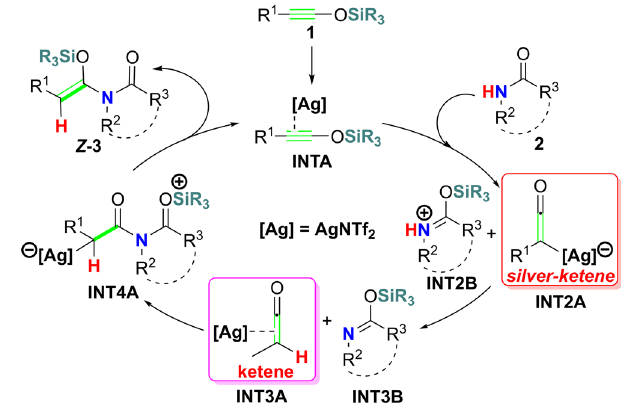
Fig. 2 Our proposed silylium ion migration dominated hydroamidation (SMH)